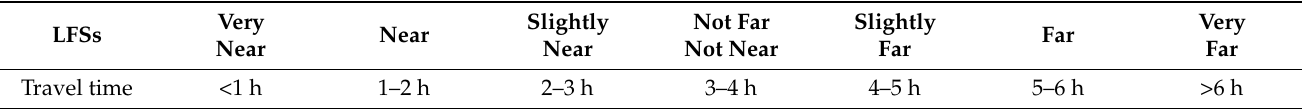
Table 4. LFSs of travel times.